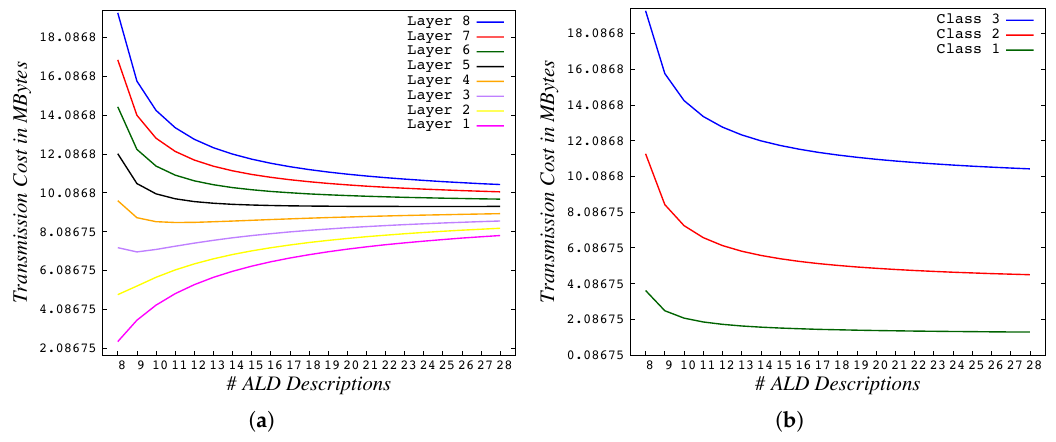
Figure 14. Transmission cost of the crew media clip for ( a ) each layer; and ( b ) each streaming class, as the STF value and associated number of ALD descriptions